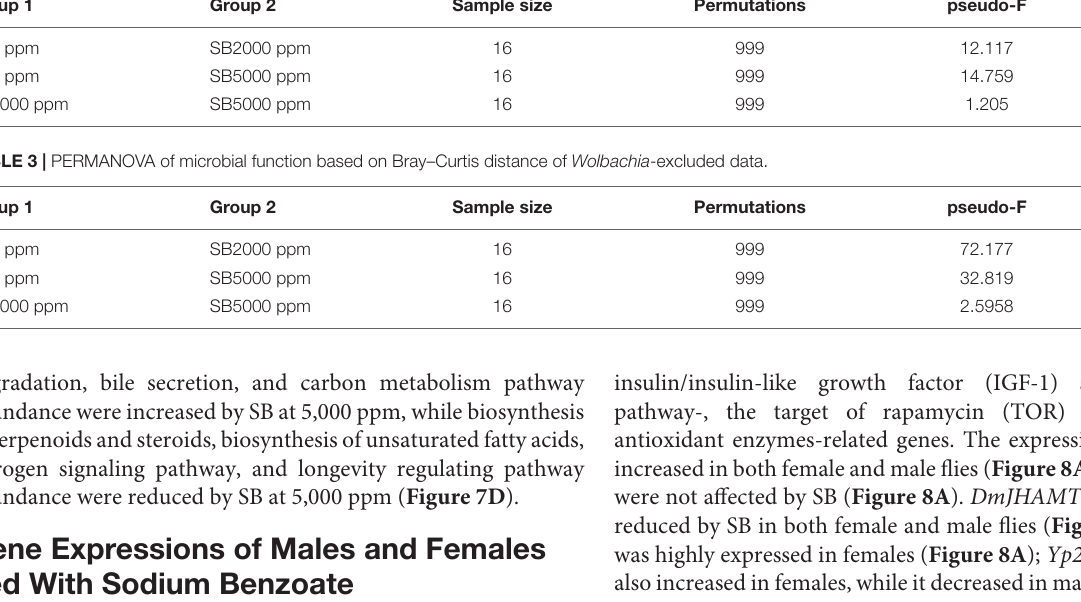
FIGURE 7 | Significant pathway (ANOVA) of the commensal microbial function of Wolbachia -excluded data. (A) Cellular processes. (B) Organismal systems. (C) Metabolism. (D) KEGG pathway at L3 level. The same letters (a, b, c) next to the bars indicate that there is a significant difference between the two groups and, otherwise, no significant difference between the two groups. TABLE 2 | PERMANOVA of microbiota based on Bray–Curtis distance of Wolbachia -excluded data. Group 1 Group 2 Sample size